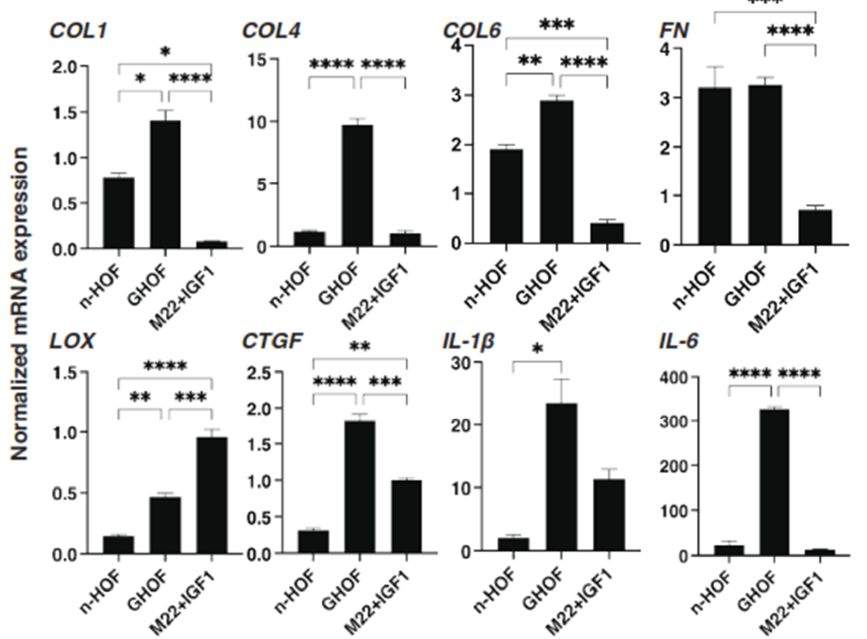
Figure 6. mRNA expression of selected ECMs and inflammatory cytokines among n-HOF-, GHOF- and M22/IGF-1-treated n-HOFs 3D spheroids. At Day 6, n-HOF-, GHOF- or 10 ng/mL M22/100ng/mL IGF-1-treated n-HOFs 3D spheroids were subjected to a qPCR analysis to estimate the mRNA expression of selected ECMs ( COL ; collagen1, 4 and 6 ) and inflammatory cytokines ( IL1β : interleukin-1β). All experiments were performed in duplicate using fresh preparations, each of which consisted of 16 spheroids. Data are presented as the arithmetic mean ± standard error of the mean (SEM). * p < 0.05, ** p < 0.01, *** p < 0.005, **** p < 0.001 (ANOVA followed by a Tukey’s multiple comparison test).